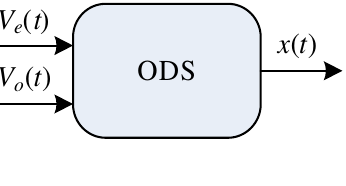
Figure 11. Instantiated ODS object composed of two inputs, P = 2 (control of the traction ( t ) , and control of the inclination angle, V force, V e the vehicle in the longitudinal direction, x ( t )